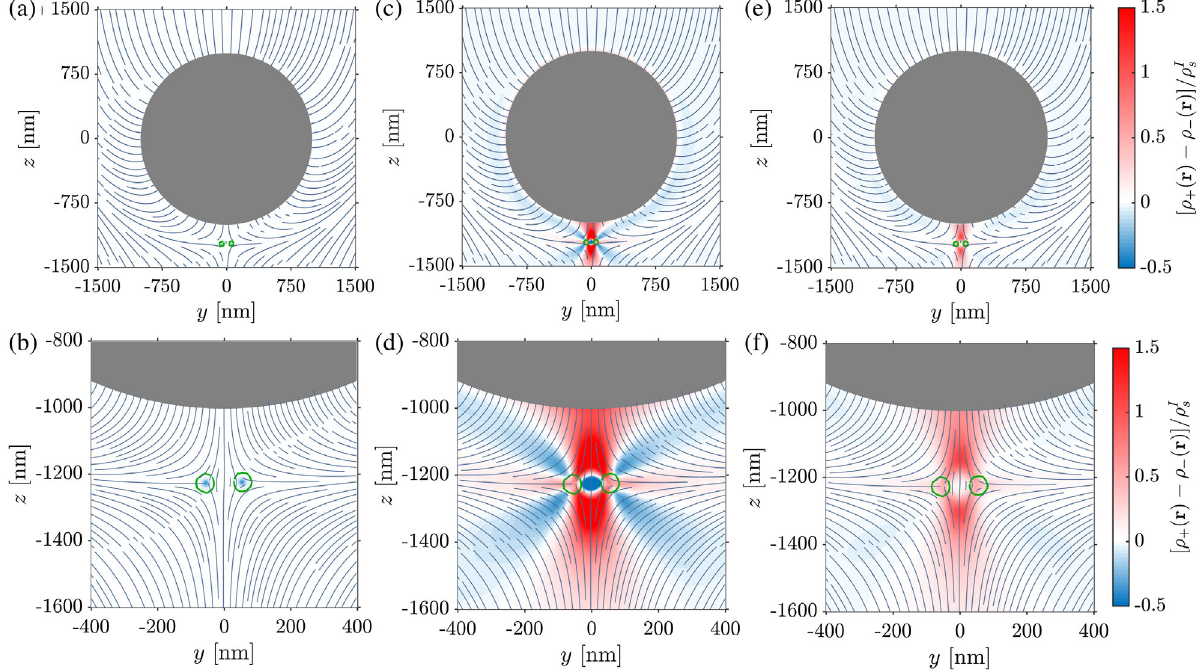
FIG. 10. Net ion-charge distributions ½ ρ ð r Þ − ρ − ð r Þ(cid:3) = ρ I s around a point defect formed next to an uncharged colloidal sphere of þ radius a ¼ 1 μ m with strong homeotropic boundary conditions. The streamlines indicate the nematic-director pattern. The first row shows the ion distribution around the particle; the second row shows a zoomed-in version around the defect. We distinguish cases with (a,b) only ion partitioning ( g ¼ 3 , g − ¼ 8 , G ¼ 0 ), (c,d) only flexoelectricity ( g ¼ 0 , q e G ¼ 10 pC m − 1 ), and (e,f) both þ (cid:1) effects ( g ¼ 3 , g − ¼ 8 , q e G ¼ 10 pC m − 1 ). In all plots, we use κ − 1 ¼ 25 nm, which results in an isotropic bulk ion þ I 1 . 8 × 10 − 5 density ρ I s ¼